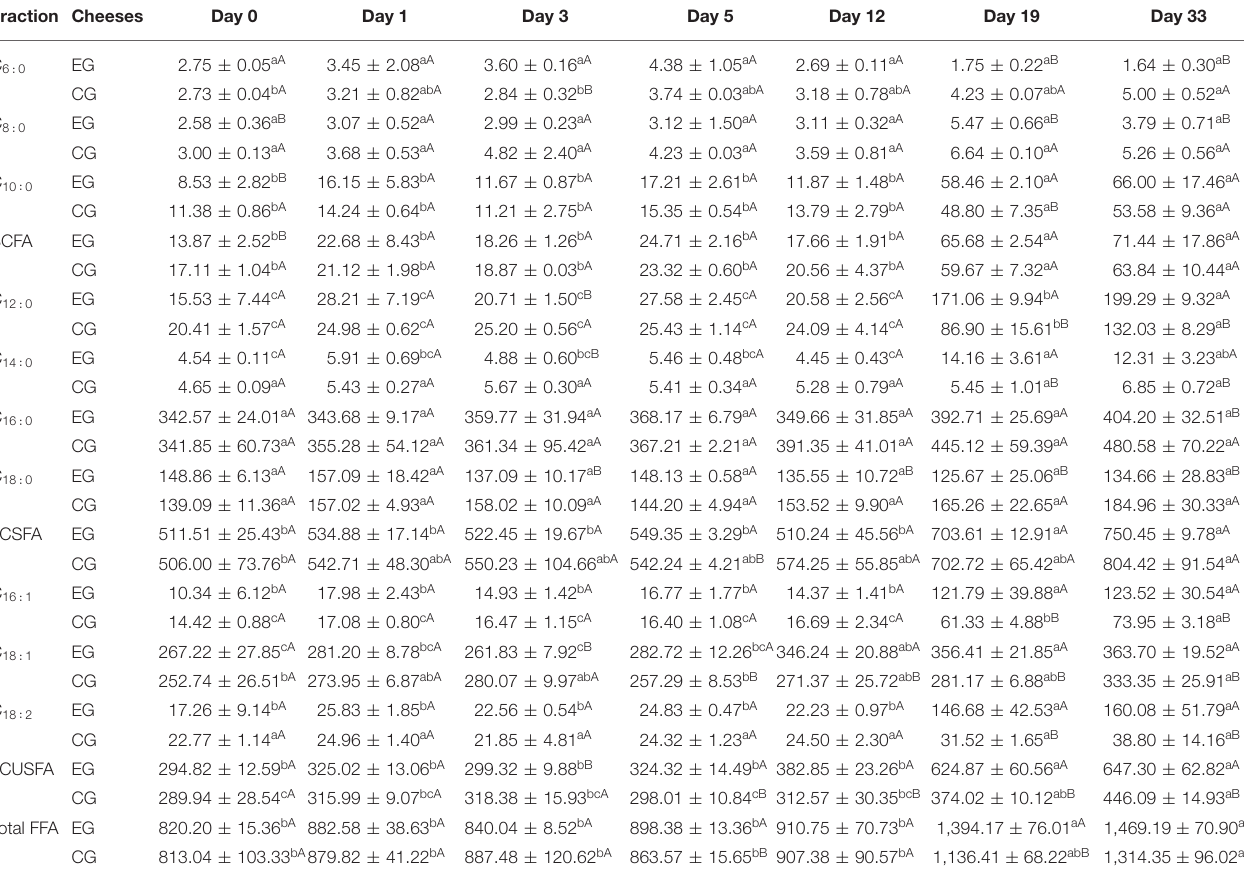
Results are indicated as Means ± SD with different superscript lowercase letters were significantly different among ripening periods within the rows each cell (p < 0.05); Means ± SD with different superscript capital letters were significantly different among cheese samples within the column of the same ripening period (p < 0.05). FFA, free fatty acids; SCFA, short-chain fatty acids (C 6 : 0 , C 8 : 0 , C 10 : 0 ); LCSFA, long-chain saturated fatty acids (C 12 : 0 , C 14 : 0 , C 16 : 0 and C 18 : 0 ); LCUSFA, long-chain unsaturated fatty acids (C 16 : 1 , C 18 : 1 , C 18 : 2 ); EG, experimental group; CG, control